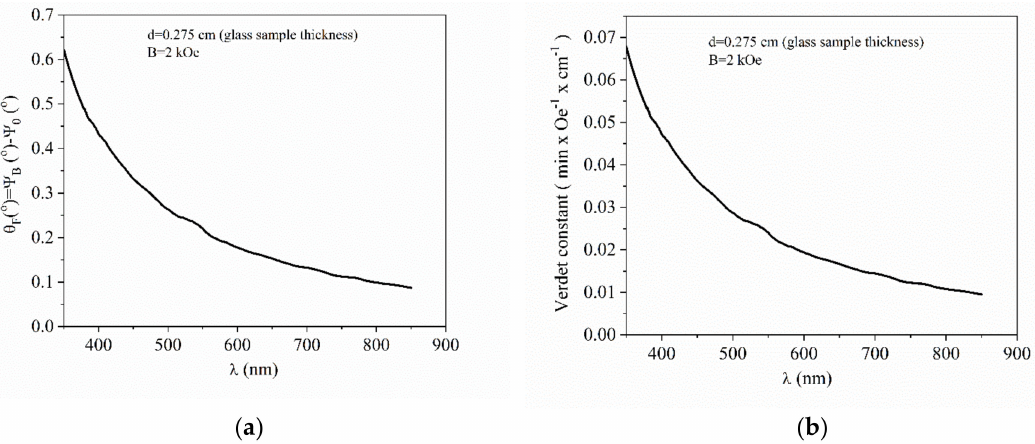
Figure 9. ( a ) Faraday rotation angle vs. wavelength (under B = 0.2 T ) and ( b ) Verdet constant vs. wavelength for Te-5 glass sample (under B = 0.2 T